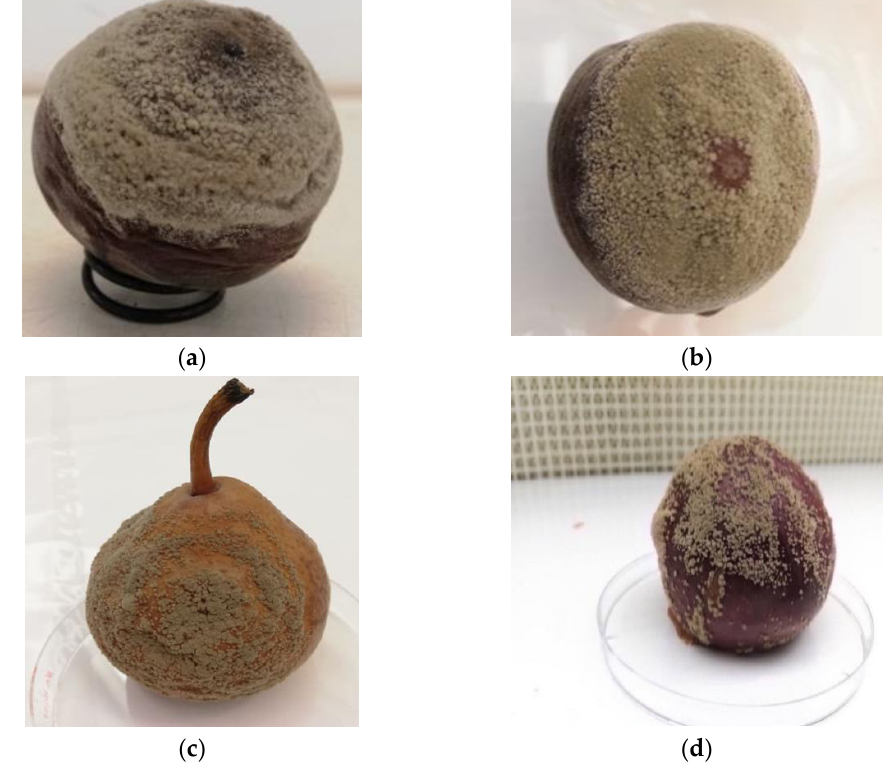
Figure 3. M. fructicola inoculum production and activation on peach ( a ) and M. laxa inoculum production and activation on peach, pear, and plum ( b , c , and d , respectively) at 7 days post-inoculation. The inoculated fruit, with 10 µL at 10 5 conidia mL −1 suspension concentration for each species, were incubated in a culture chamber at 24/18 °C and 16/8 h light/dark photoperiods, in clear plastic boxes with maximized relative humidity.